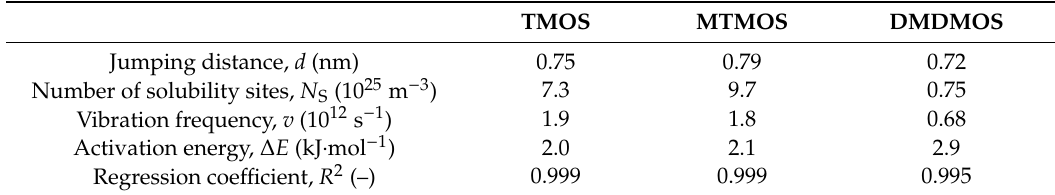
Figure 10. Temperature dependence of the permeance for several gas species through ( a ) TMOS-, ( b ) MTMOS-, and ( c ) DMDMOS-derived membranes. Lines represent the fitted results. Table 5. Solid-state diffusion model Equation (8) factors for hydrogen permeation through the TMOS-, MTMOS-, and DMDMOS-derived membranes.